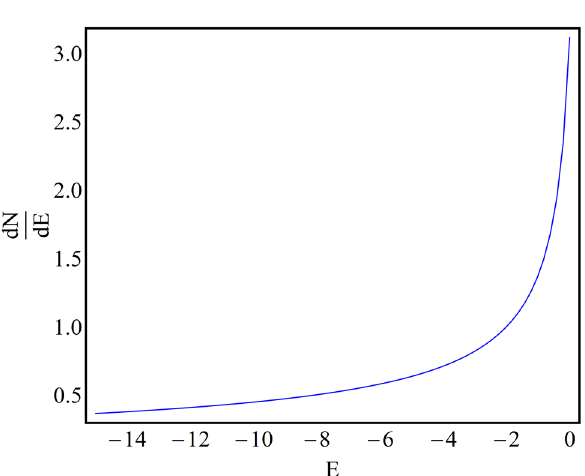
Figure 6. Stability analysis of obtained solution. The slope of norm N w.r.t. E is plotted as a function of chemical potential ( E ) diagrams as a function of the E Vs with G 1